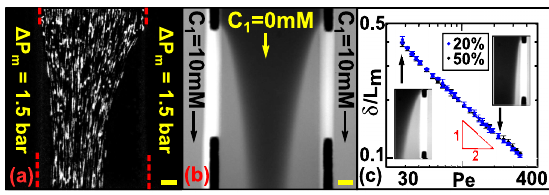
FIG. 4. (a) In the three-channel device [Figs. 1(b), 1(c), and 2], the amount of convection admitted by HMMs at large trans- membrane pressure drops, here (cid:1) P m ¼ 1 : 5 bar , is lower for a highly cross-linked HMM (50% v/v, left) than for a lightly cross- linked HMM (20%, right). Tracer particles are focused towards the center of the channel by transmembrane flow from the side channels. (b) The diffusive flux through a lightly cross-linked membrane (20% v/v, right) is nearly identical to that through a highly cross-linked (50% v/v, left) membrane. (c) After diffusing through each HMM, the pH buffer is convected downstream, forming a boundary layer whose thickness decreases with Peclet number (flow velocity) like Pe 1 = 2 , as expected for 2D convection-diffusion. Scale bars: 20 (cid:1) m